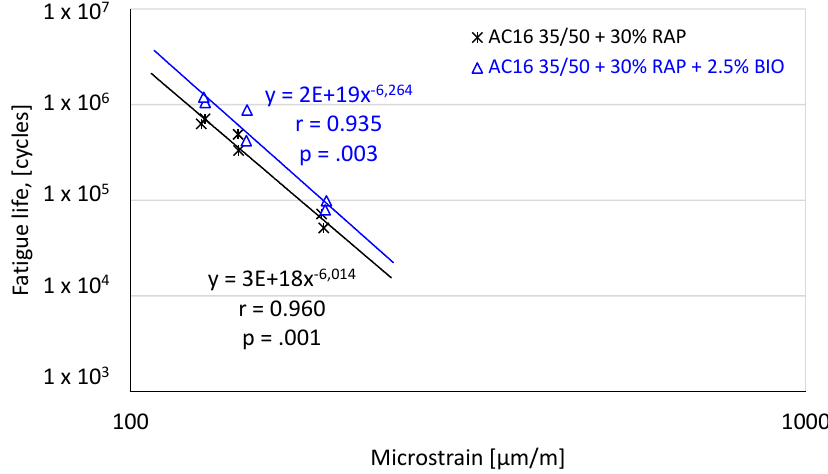
Figure 7. Fatigue characteristics of asphalt mixtures.